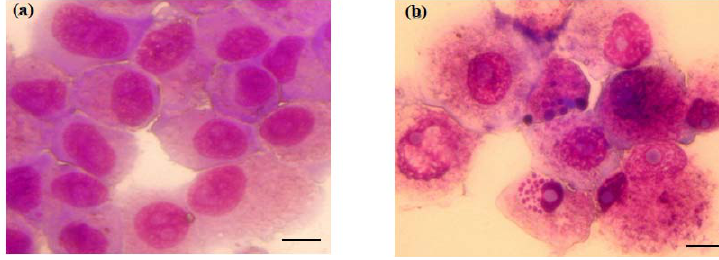
Figure 2. Apoptotic morphology of A549 cells treated with bufalin. A549 cells were treated with vehicle ( a ) or 100 nmol/L bufalin ( b ) for 48 h and stained by Giemsa staining. cytoplasmic shrinkage, nuclear condensation and the formation of apoptotic bodies were observed in ( b ). Shown are representative images of three independent experiments.